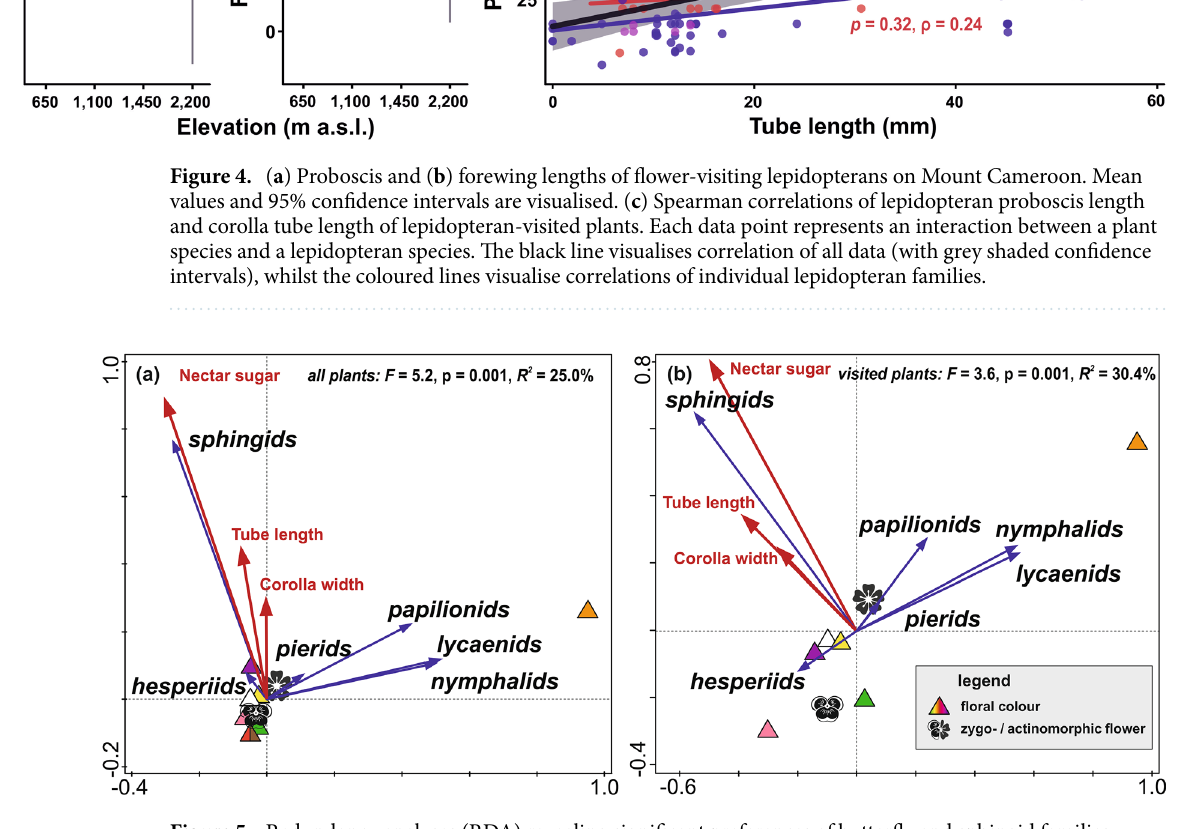
Figure 5. Redundancy analyses (RDA) revealing significant preferences of butterfly and sphingid families (represented by blue arrows) to floral traits (represented by red arrows and various symbols) on Mount Cameroon. The two RDA models were run for ( a ) all flowering plant species, and ( b ) the plant species visited by butterflies or